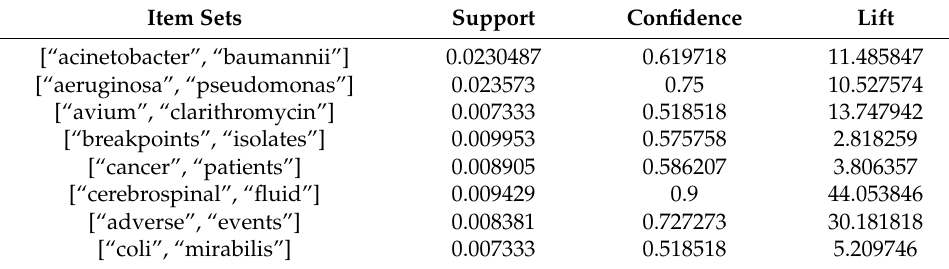
Table 3. Sample item sets of amikacin dataset.